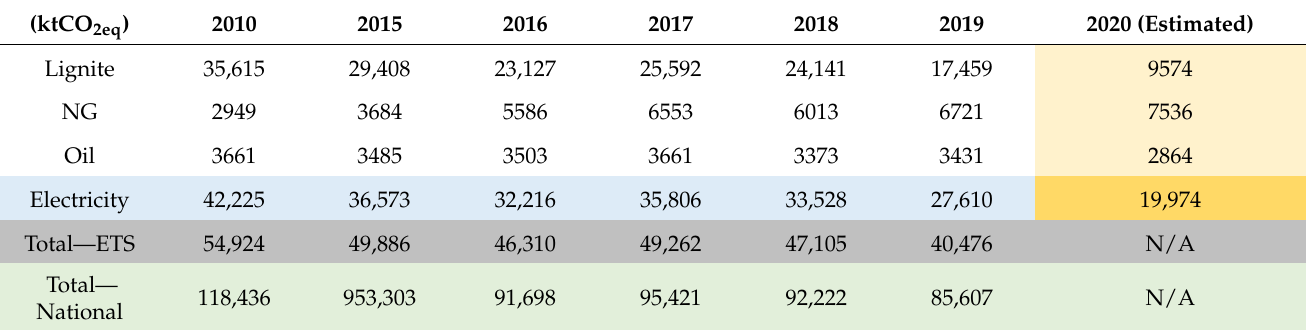
Table 6. Electricity Verified